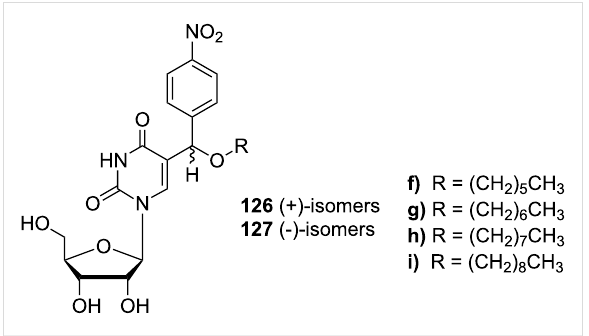
Figure 20: 5-[alkoxy-(4-nitro-phenyl)-methyl]uridines 126 and 127